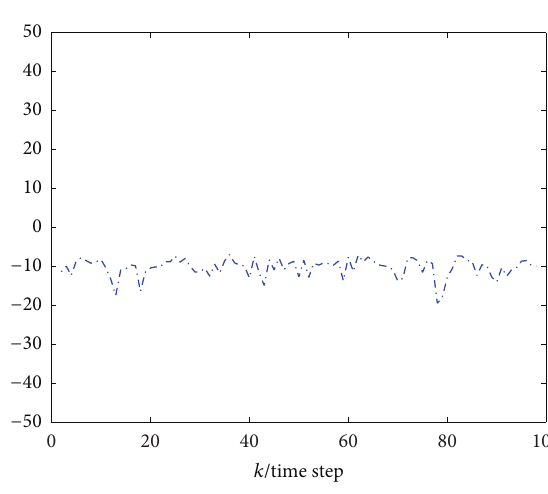
Figure 3: log(MSE1) (Case